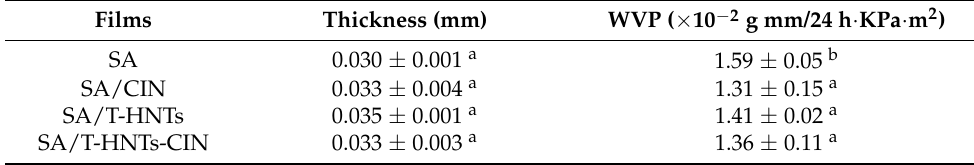
Table 2. Water vapor permeability of SA-based composite film.